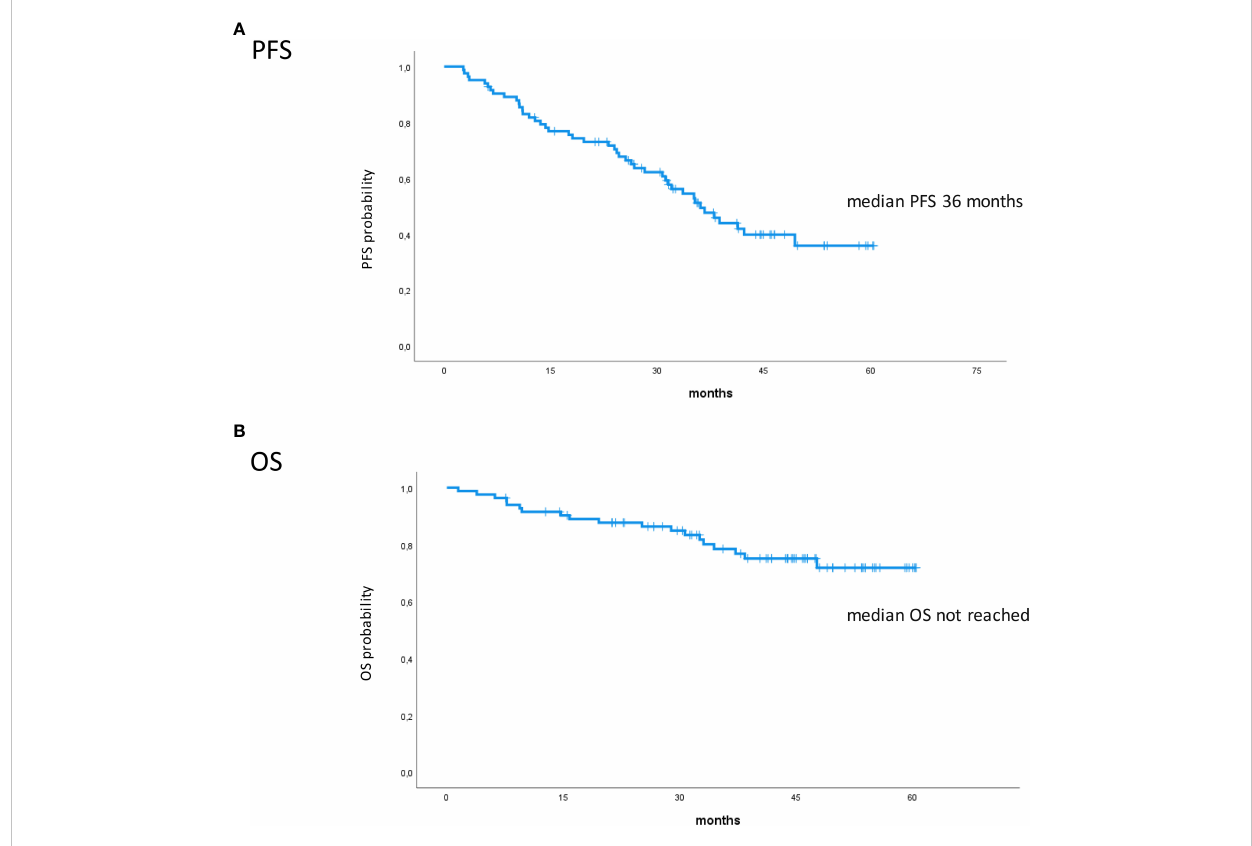
FIGURE 2 Kaplan – Meier survival curves. (A) PFS in all patients. (B) OS in all patients. PFS, progression-free survival; OS, overall